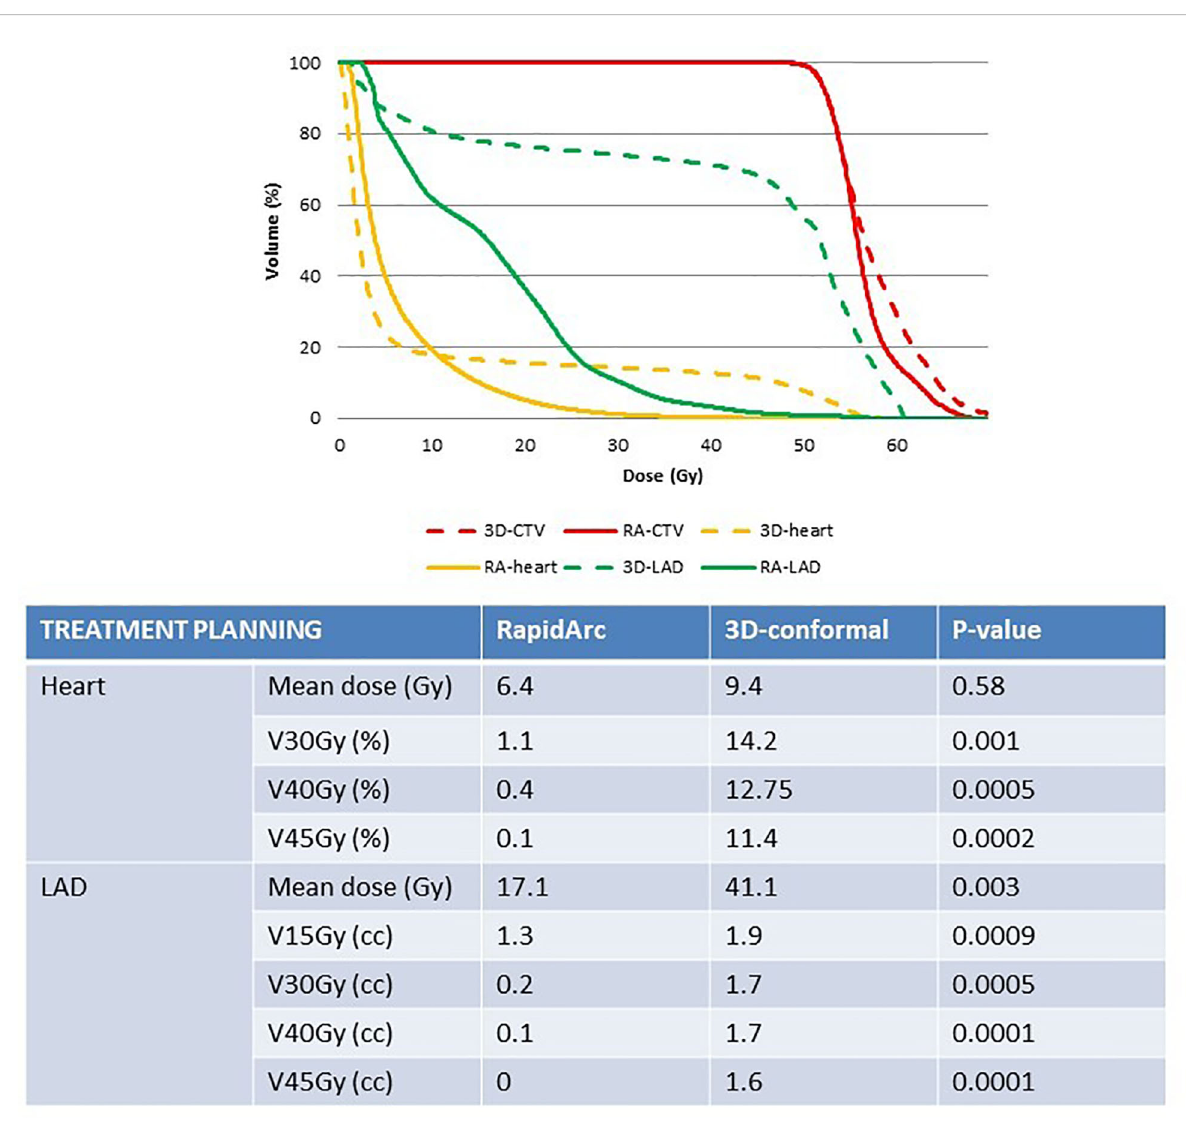
FIGURE 2 Comparison of heart and LAD exposure in the radiotherapy plans (3D-conformal versus RapidArc-based IMRT) for similar target coverage. 3D, 3D-conformal; RA, RapidArc; CTV, clinical target volume; LAD, left anterior descending coronary